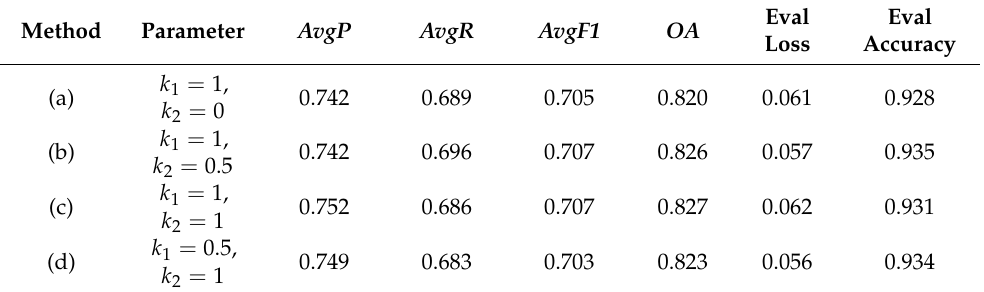
Table 3. The comparison of elevation information at different proportions on